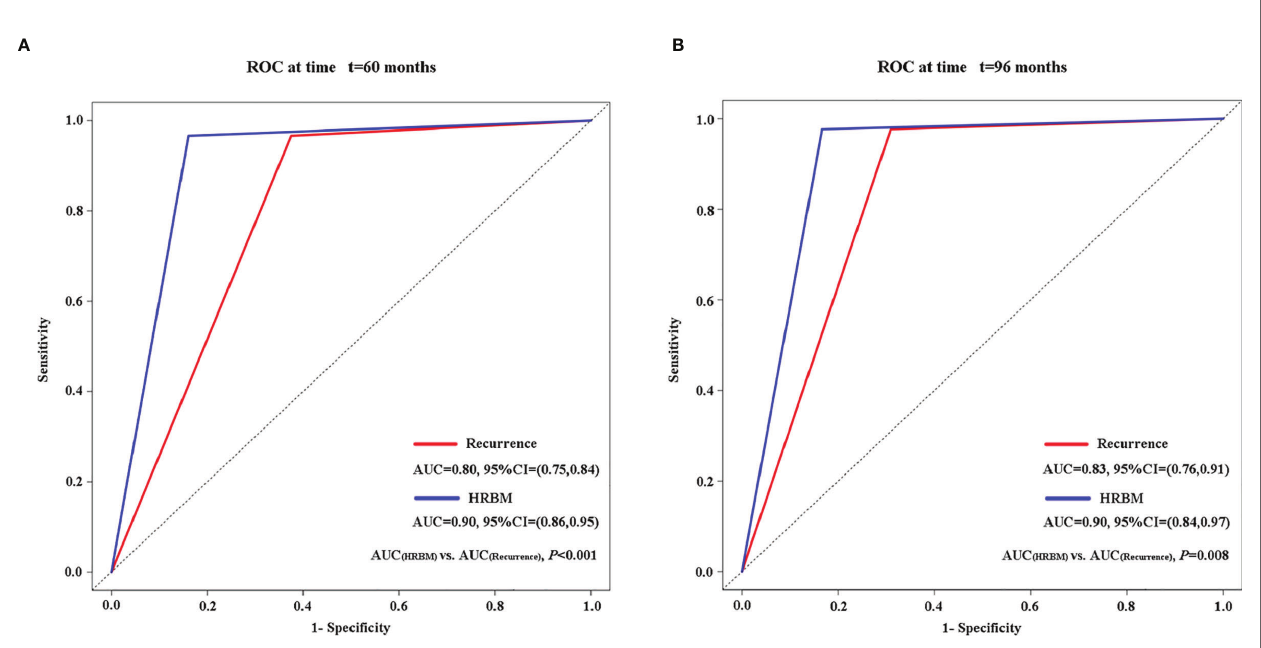
FIGURE 3 | Comparison of the ability of HRBM and recurrence to predict overall survival by the time-dependent ROC and the estimated AUC at 5 years (A) and 8 years (B) . AUC, area under the curve; HRBM, HCC recurrence beyond the Milan criteria; ROC, receiver operating